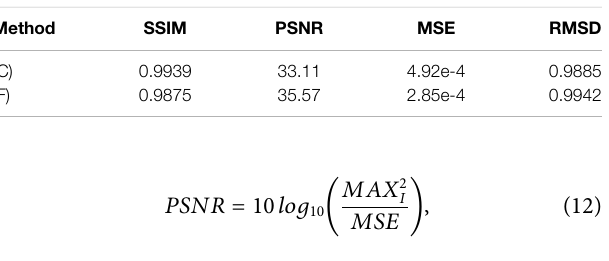
TABLE 8 | All the metric values of the recovered stress maps in Figure 9